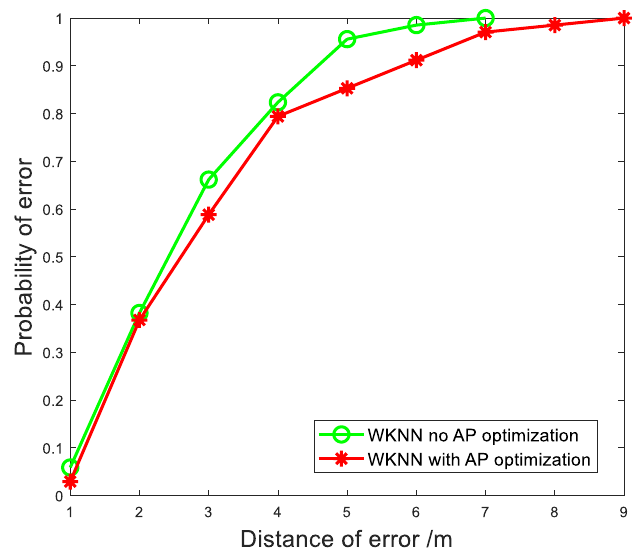
Figure 9. Probability of error of WKNN algorithm.